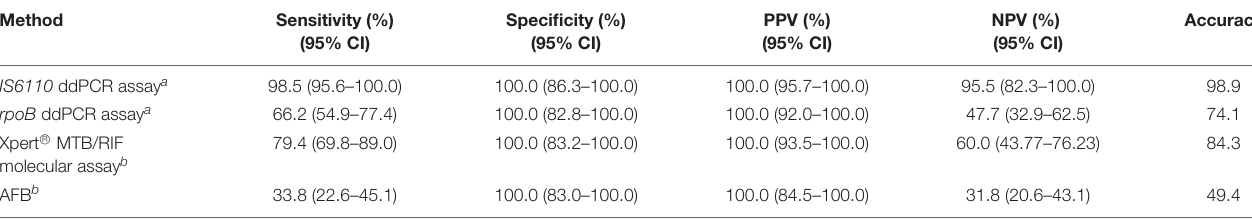
FIGURE 1 | Linear correlations between the expected and the observed IS6110 (A) and rpoB (B) load, expressed as log 10 copies/10 6 cells. IS6110 (C) rpoB (D) load in the first and second experiment were shown in dark and light gray, respectively. Each value was tested in two independent experiments, each led in duplicate. Bars represent mean (+SD). TABLE 2 | Performances of homemade ddPCR assays, Xpert R (cid:13) MTB/RIF molecular assay, and AFB against MTB